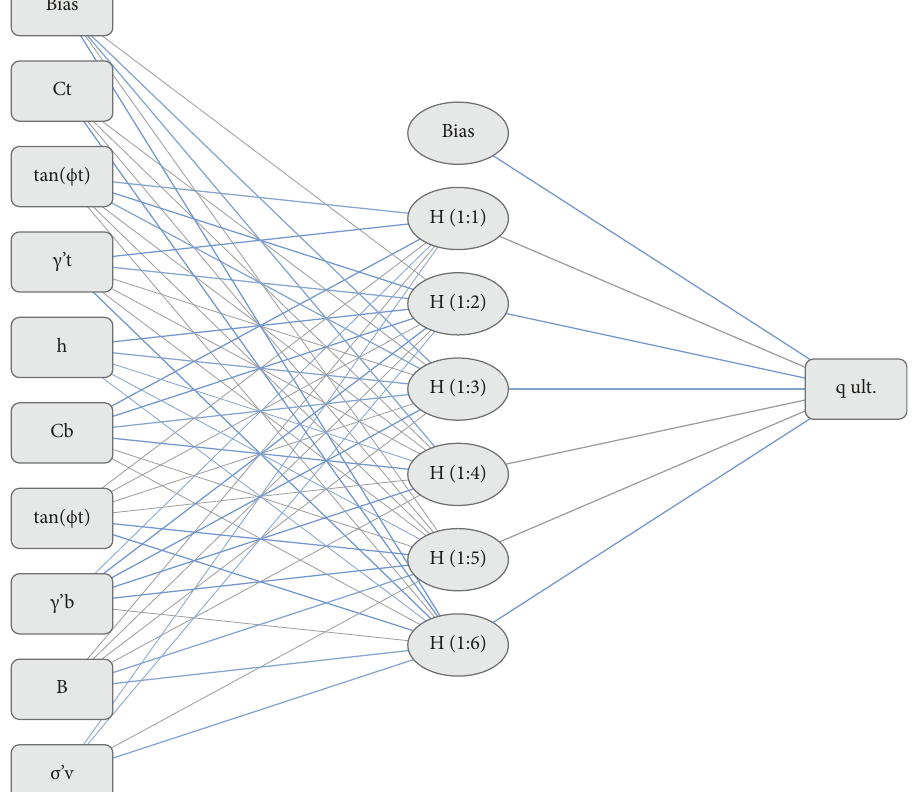
Figure 5: Layout for the developed ANN